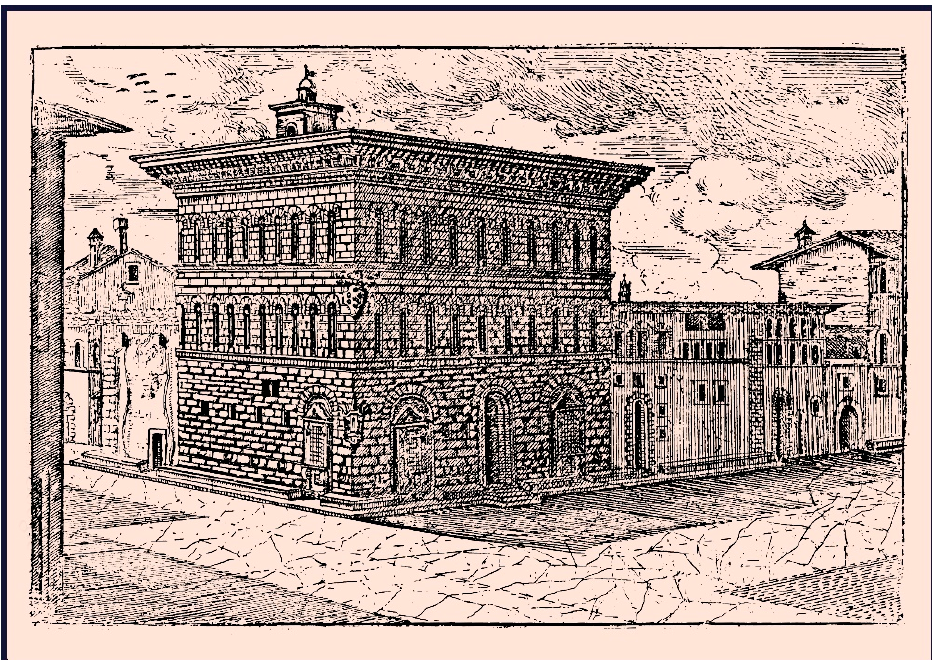
Figure 3. View of Palazzo Medici from the second half of the 17th century [16].